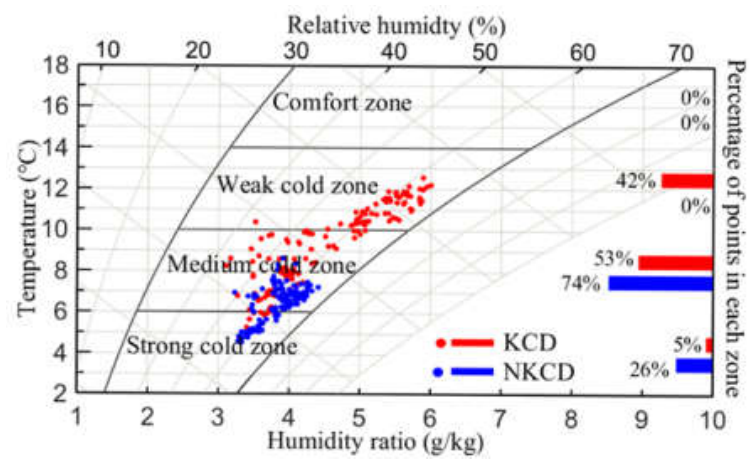
Figure 12. Variation of air temperature.